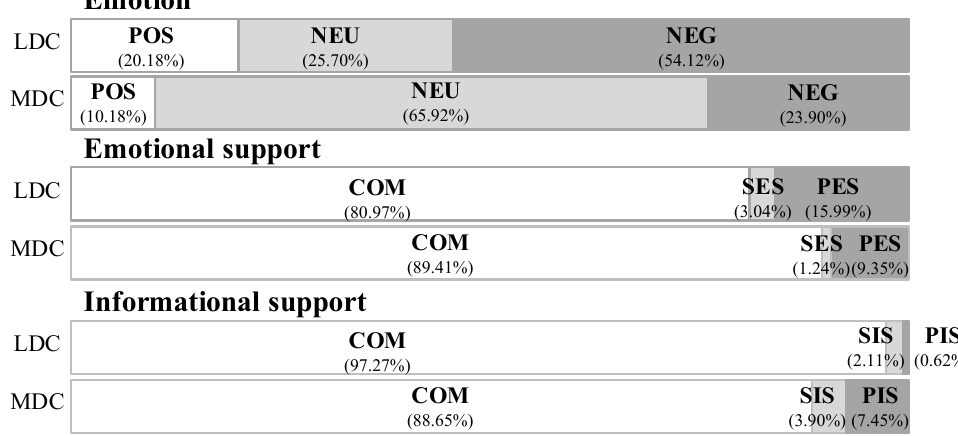
Figure 2. Proportion of postings of each type in the management depression community (MDC) and lacking-management depression community (LDC).